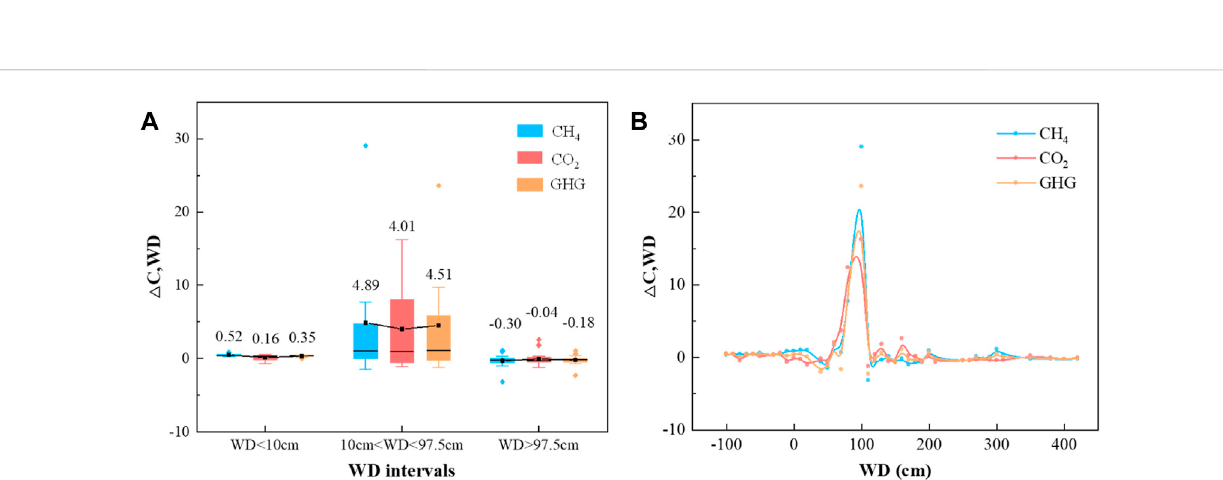
Frontiers in Earth